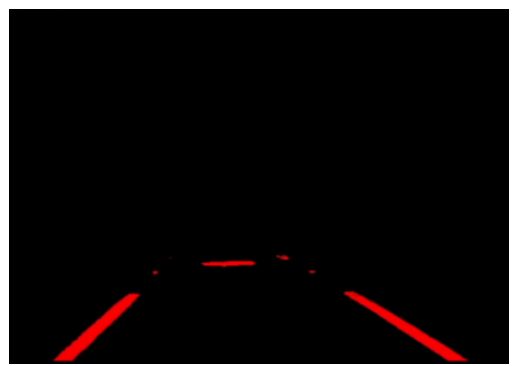
Figure 7. Thresholding of the interest area.